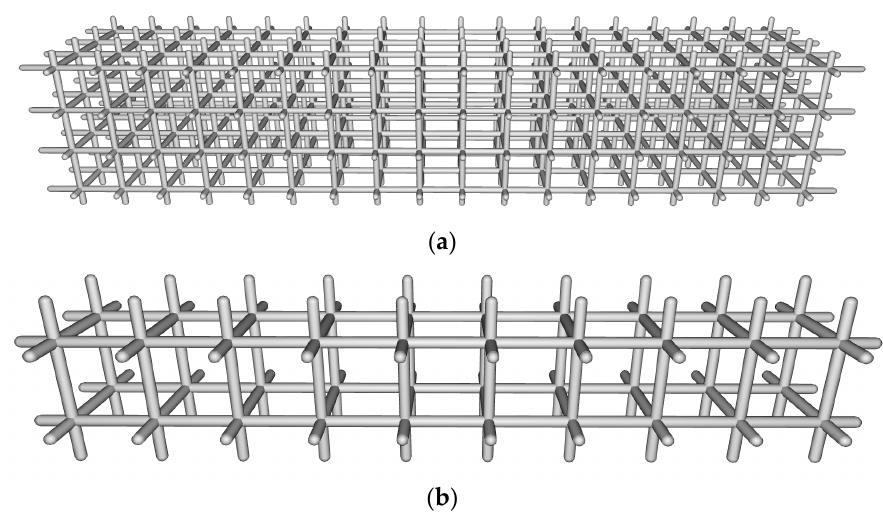
Figure 5. Two different lattice designs with identical relative density: ( a ) the lattice has a small cell size with a thin strut diameter, ( b ) the lattice has a larger cell size with a thicker diameter.